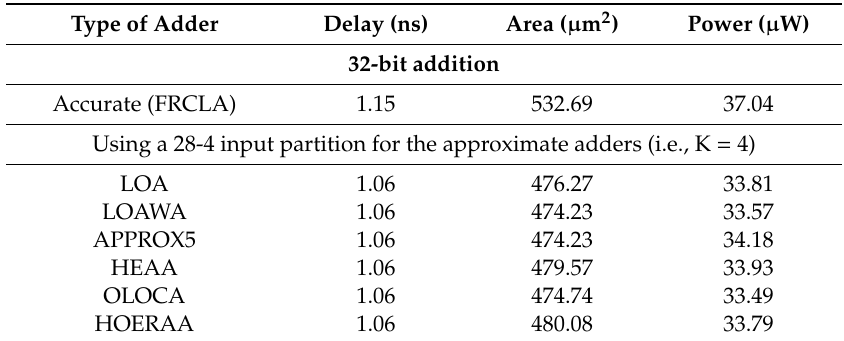
Table 2. ASIC-based design metrics corresponding to accurate and approximate 32-bit and 64-bit adders estimated using a 32 / 28nm CMOS